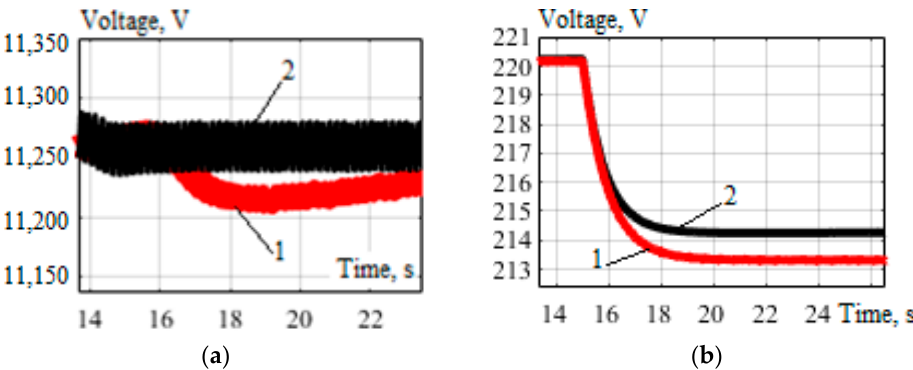
Figure 14. Time dependencies for voltages in the case of a decrease in solar irradiance: ( a ) on the HV side of PRs; ( b ) on the LV side of PRs (DC grid); 1—non-regulated PRs; 2—regulated PRs. The results of voltage regulation with the help of energy storage units in the case of a decrease in solar irradiance are shown in Figure 15.